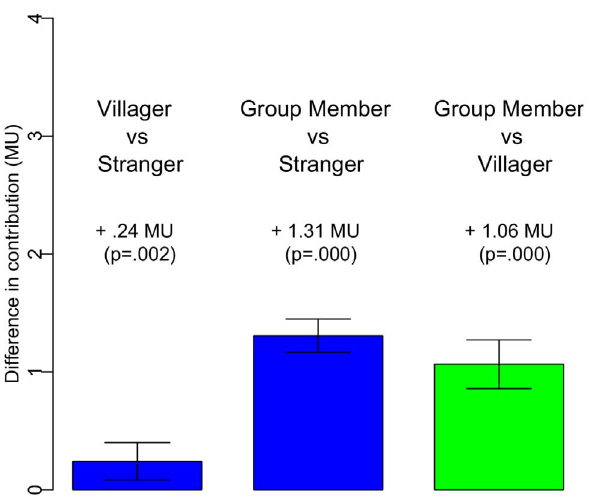
Figure 2. Treatment effect of the two variants of the dictator game. Participants allocated 0.24 MUs more to co-villagers and 1.31 MUs more to farmer group co-members (blue bars) than to ‘strangers’. Importantly, participants allocated 1.06 MUs more to farmer group co- members than to co-villagers (green bar). N=2421. Whiskers indicate the 95%